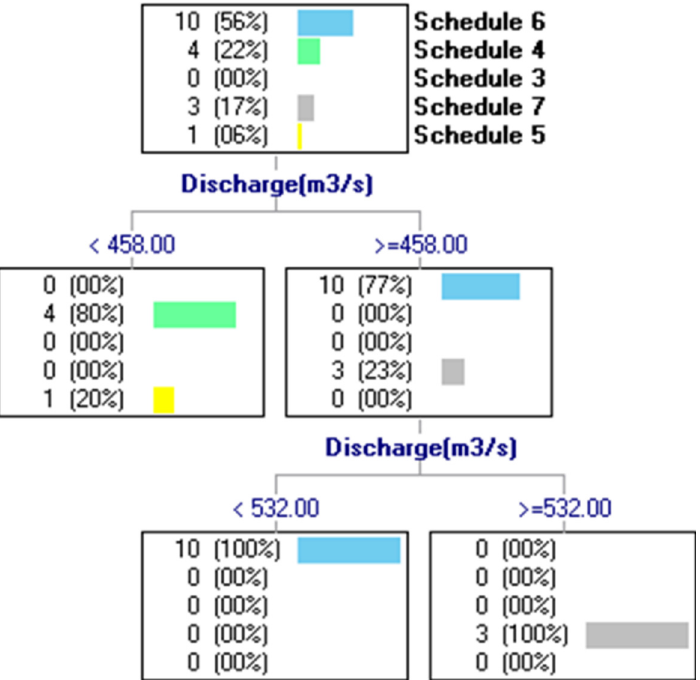
Figure 9. Decision tree by using the Iterative Dichotomiser 3 (ID3) algorithm Tianshengqiao plant 1 for the winter season.